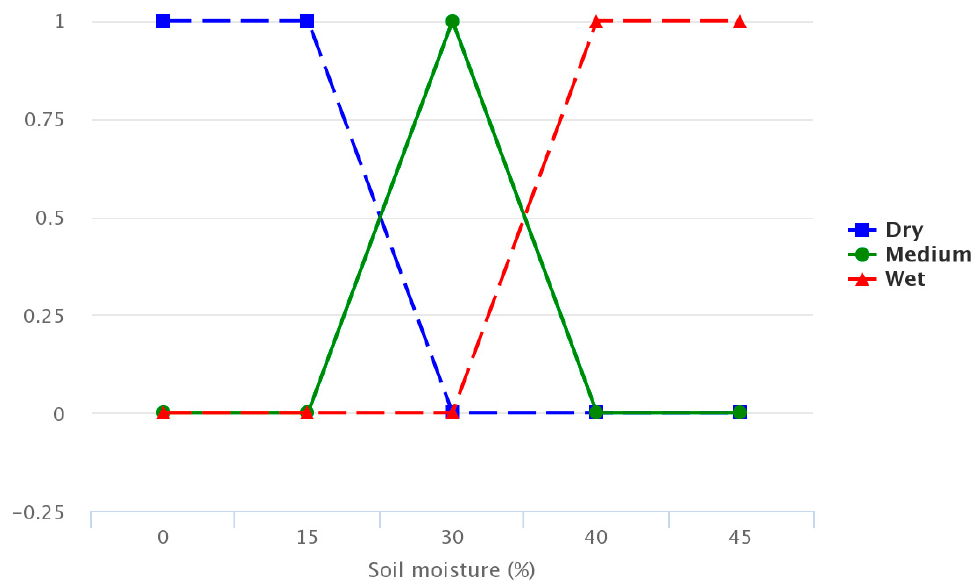
Figure 10. Soil inference rule.